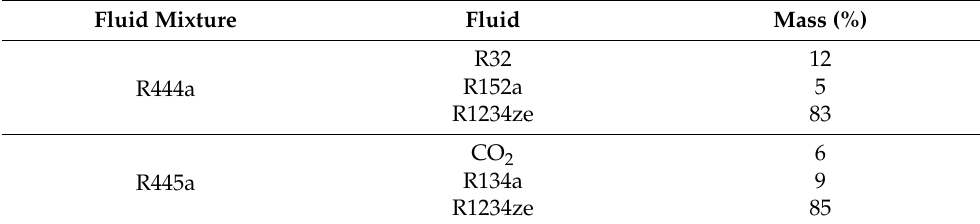
Table 3. Mass Percentage Composition of R444a and